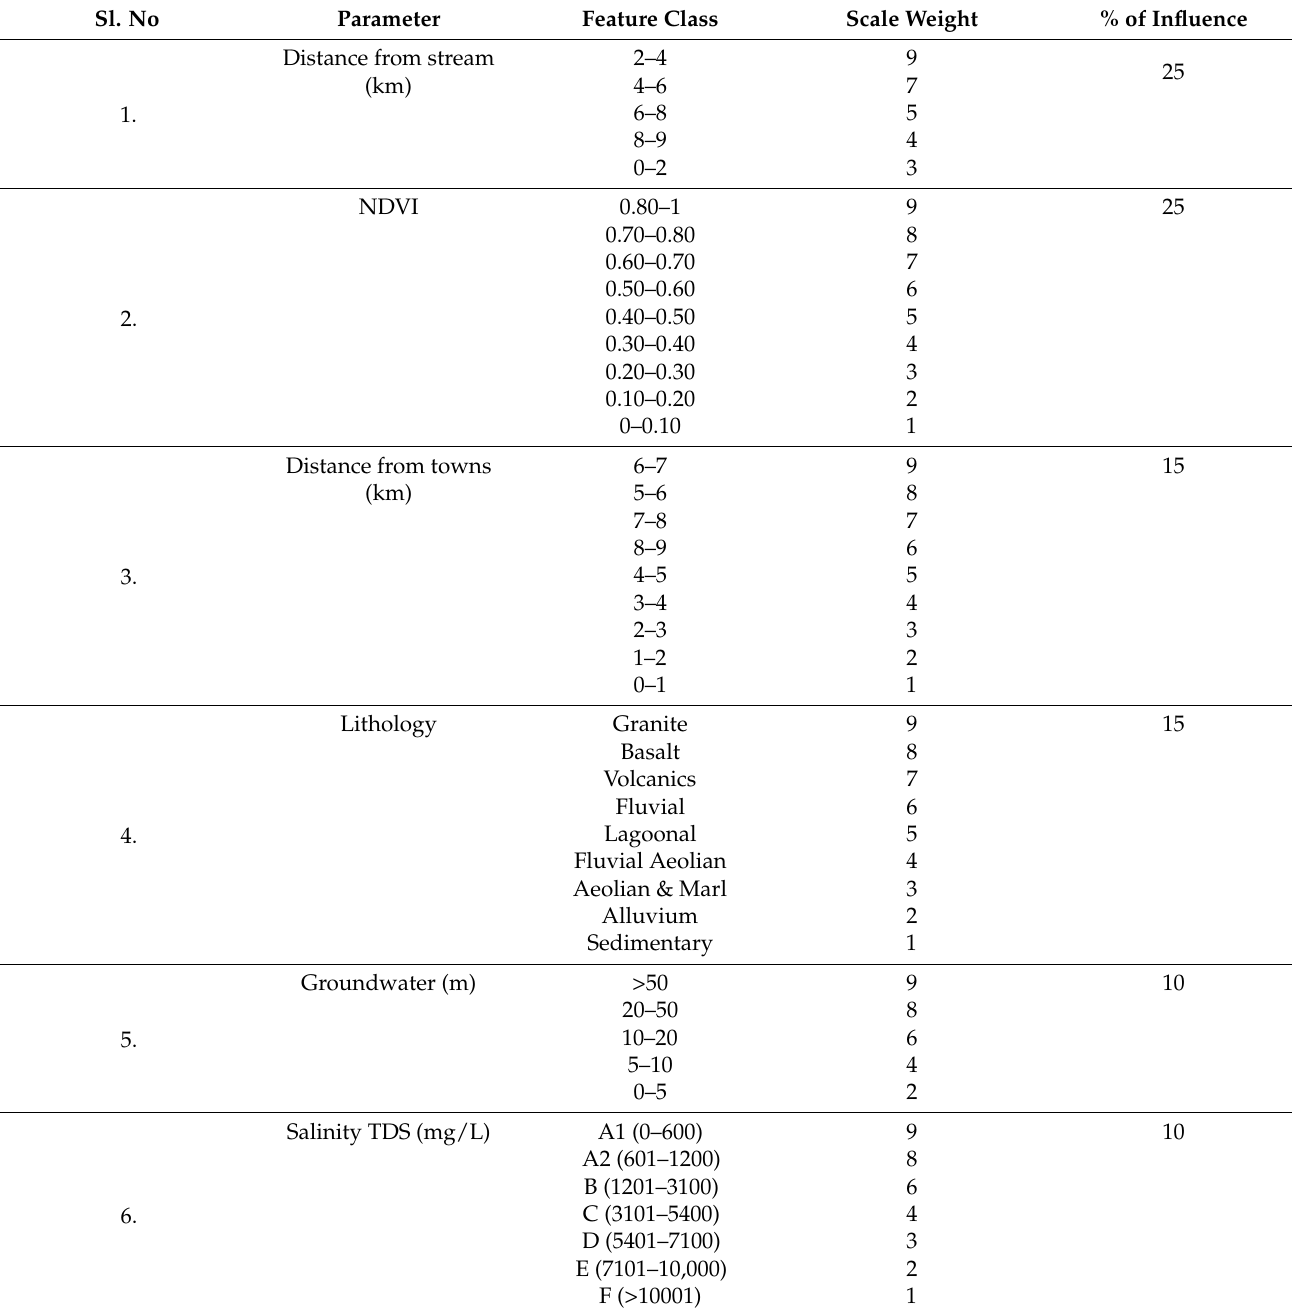
Table 2. Reclassified layers and their preference